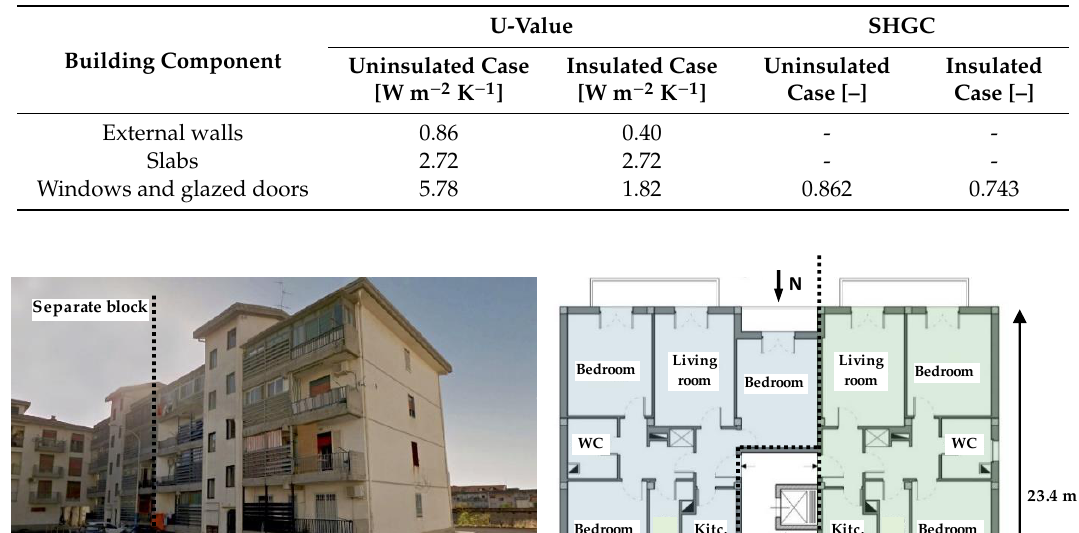
Table 3. Features of the envelope for the selected building.